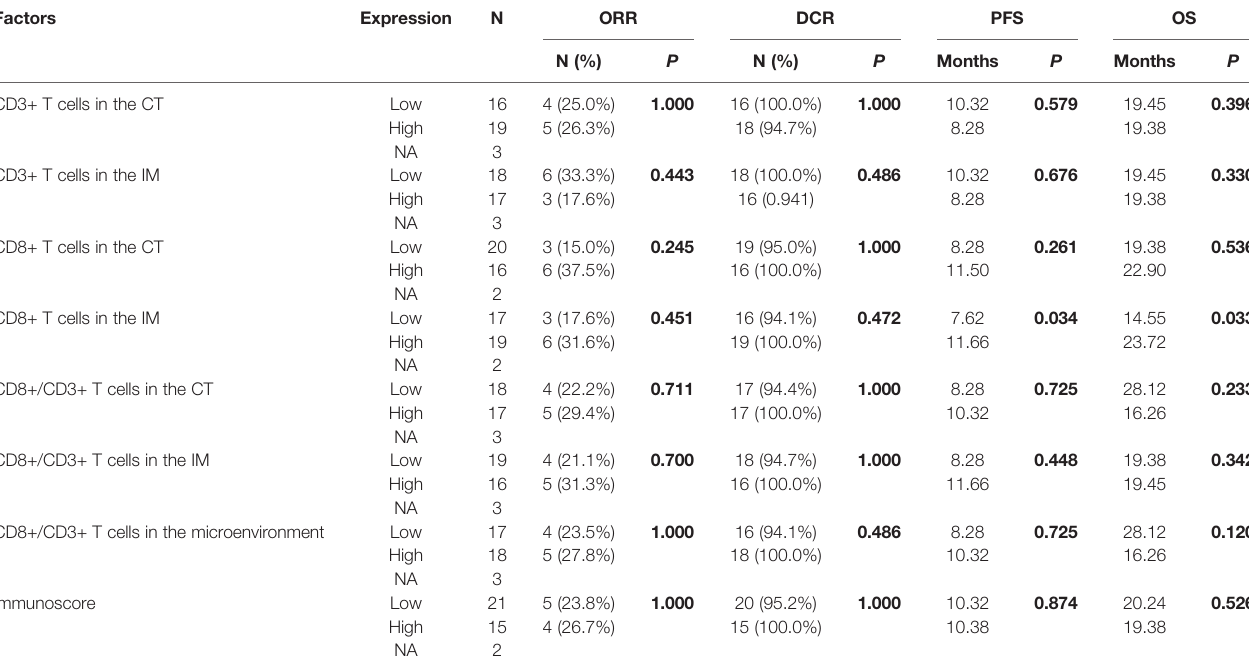
Bold values indicate P < 0.05; CT, Core of the tumor; DCR, Disease control rate; IM, Invasive margin; PFS, Progression-free survival; NA, Not applicable; ORR, Overall response rate; OS, Overall